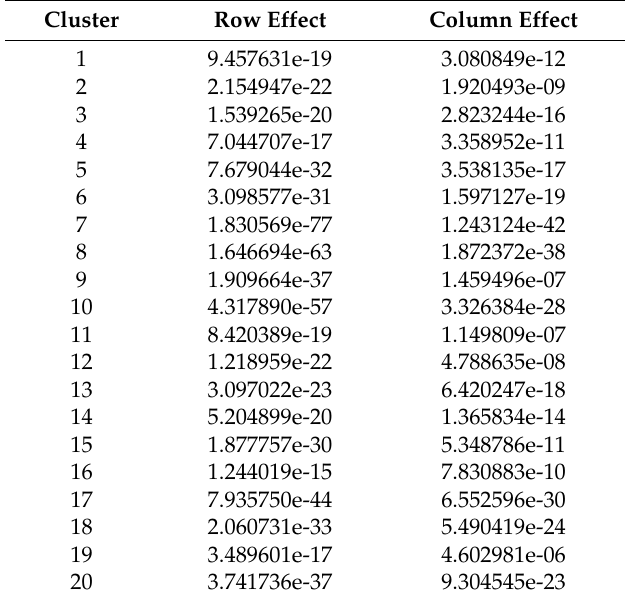
Table 2. The p -values of the F-statistics from the two-way